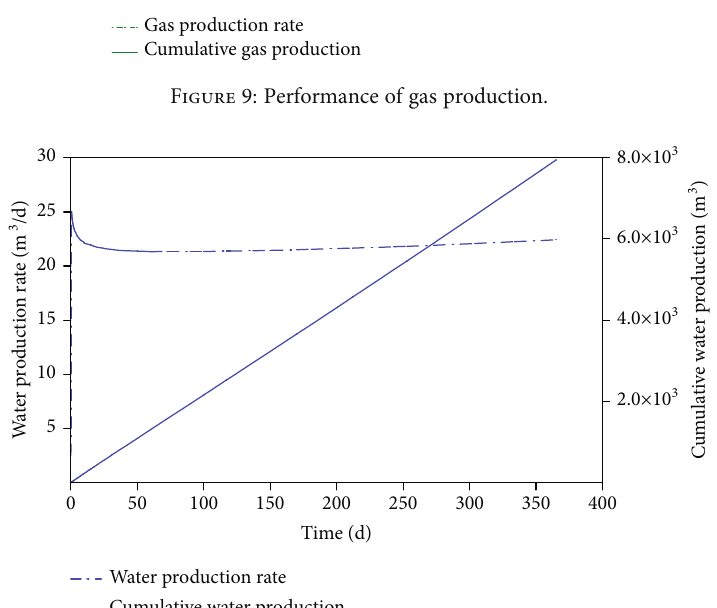
Figure 10: Performance of water